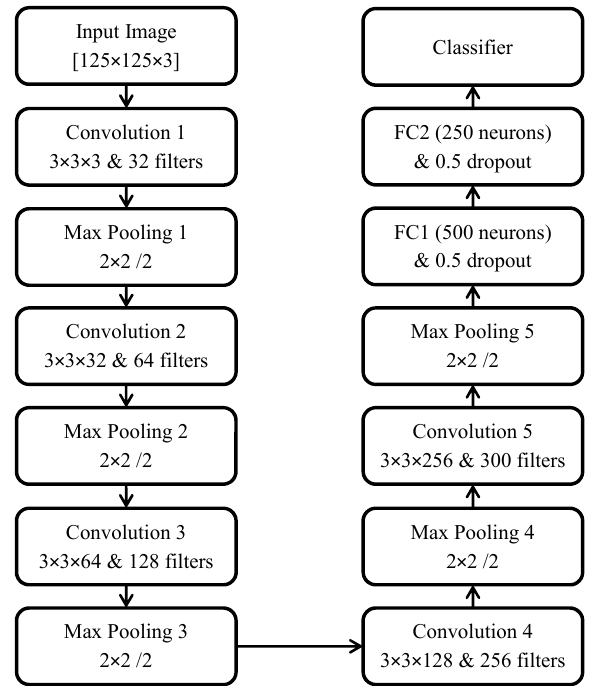
Figure 4. Proposed customized model architecture for malaria